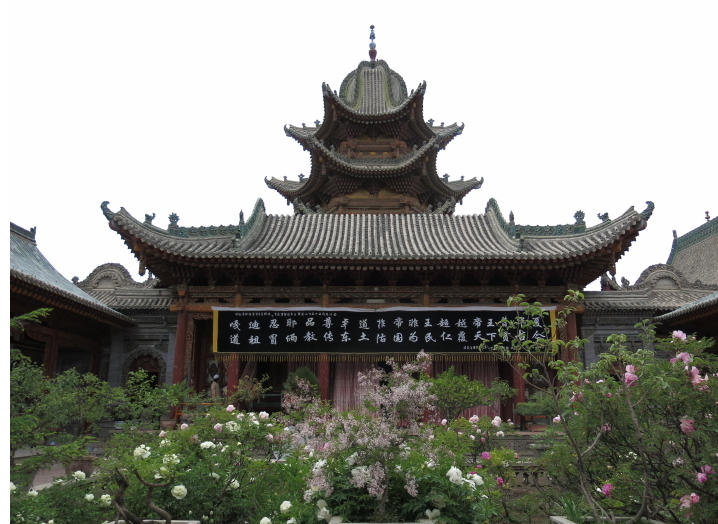
Figure 6. The Taizi Qubbah of Qadriyyah Sufi Order, Hezhou City (Photo by Zhou Chuanbin, 2014). Chinese Muslims call Sufi shrines (tombs of Sufi masters) Qubbah, which means “dome” in